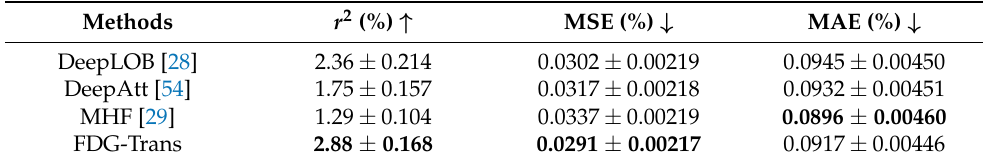
Table 2. Performances of FDG-Trans and 3 other hybrid